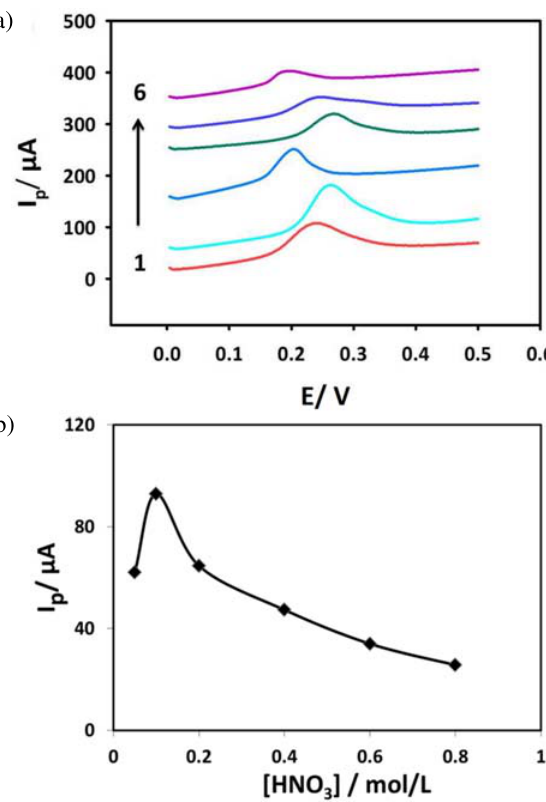
Figure 3: a) Square wave anodic stripping voltammograms Figure 4: a) Square wave anodic stripping voltammograms (SWASVs) of 6.2 × 10 –7 mol/L Hg(II) in 0.1 mol/L acetate buffer, (SWASVs) of 6.2 × 10 –7 mol/L Hg(II) in 0.1 mol/L acetate pH 5.5 at GPE surfaces pretreated in 1) 0.05, 2) 0.1, 3) 0.2, 4) 0.4, 5) 0.6 and 6) 0.8 mol/L HNO . Working conditions: Pretreatment 3